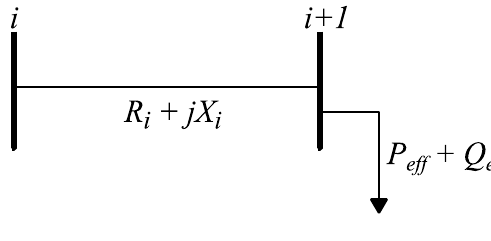
Figure 5. Simple Distribution Line.